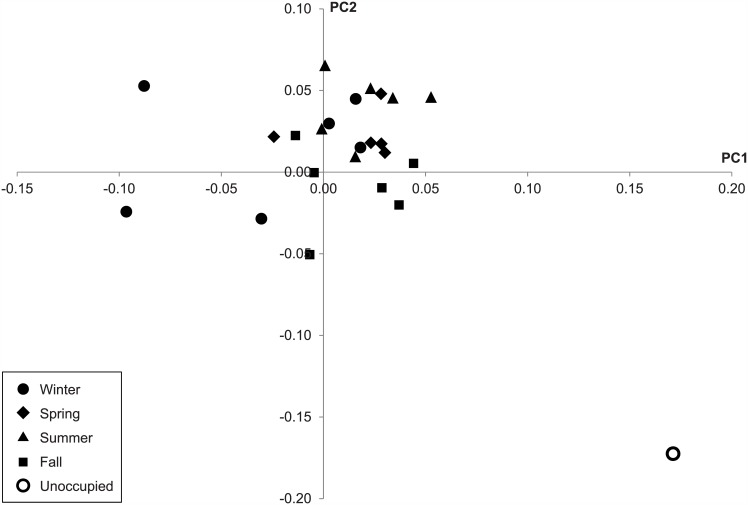
PCoA analysis of weighted UniFrac distance showing individual samples by season and one unoccupied sample.